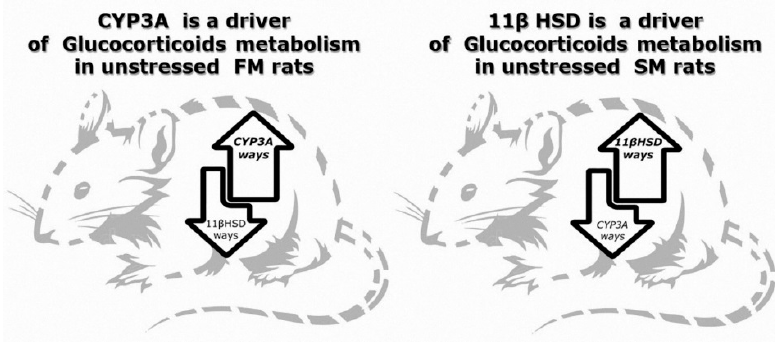
Figure 1. Key pathways of glucocorticoid tissue metabolism of in fast (FM) and slow (SM) metabolizers.